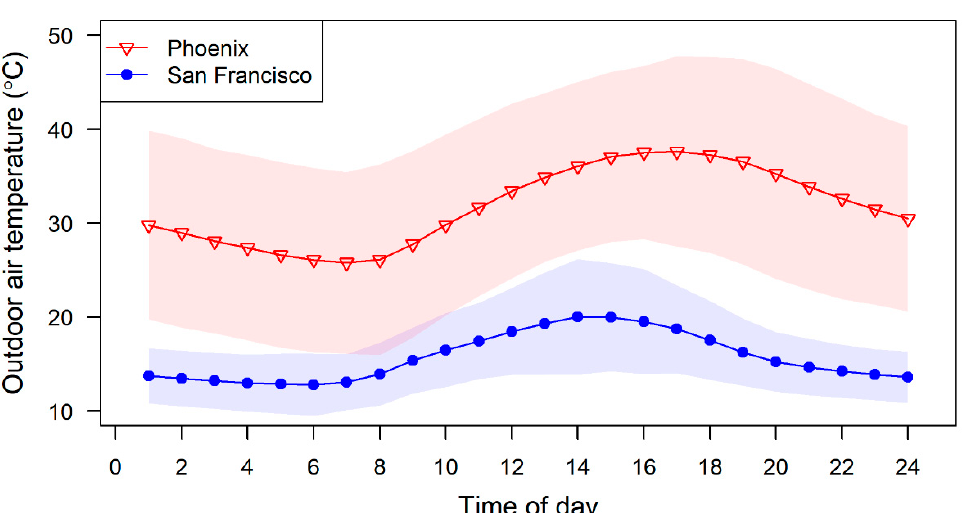
Figure 1. Hourly average outdoor dry-bulb temperature in Phoenix, AZ and San Francisco, CA during 106 weekdays from 1 June to 31 October. Shaded areas indicate above and below two standard deviations from the estimated mean.